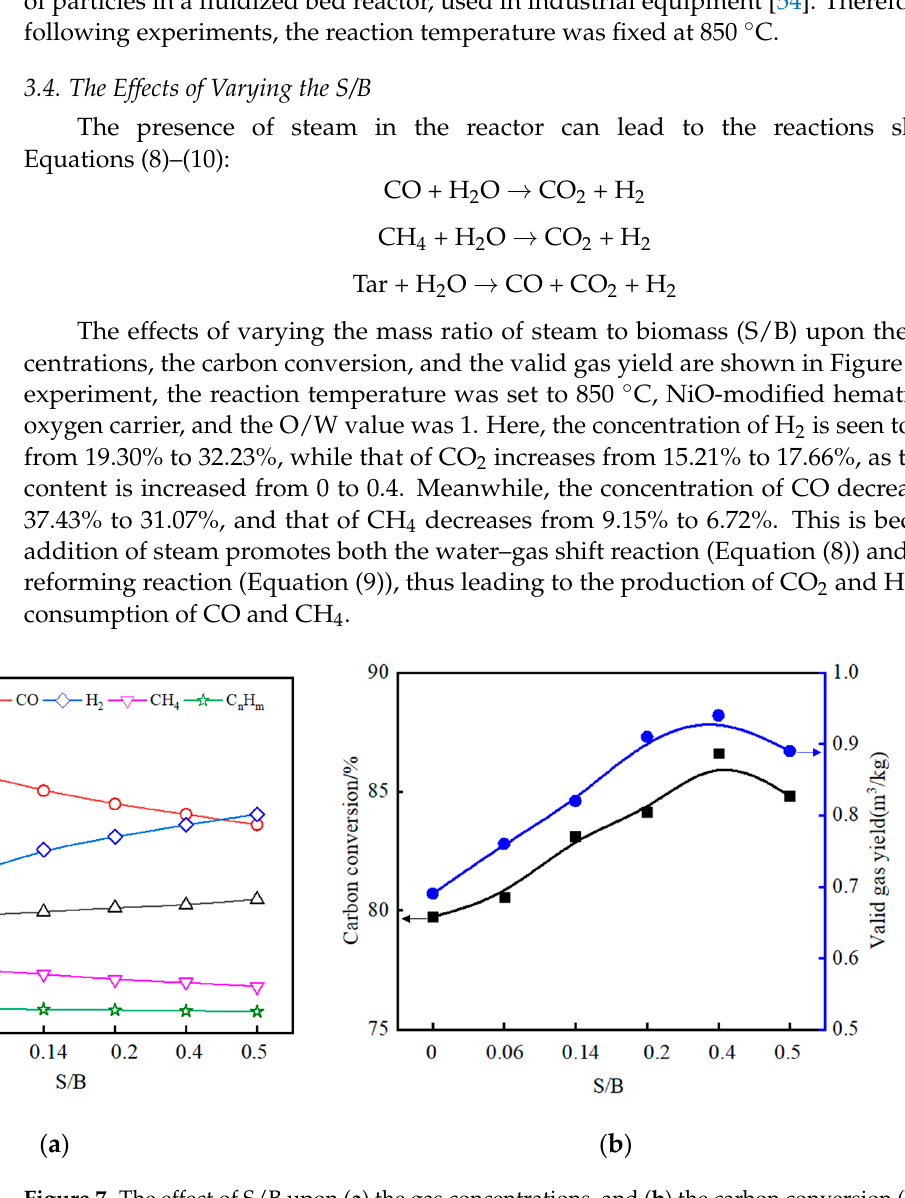
Figure 7. The effect of S/B upon ( a ) the gas concentrations, and ( b ) the carbon conversion (black) and valid gas yield (blue) during wood waste gasification.